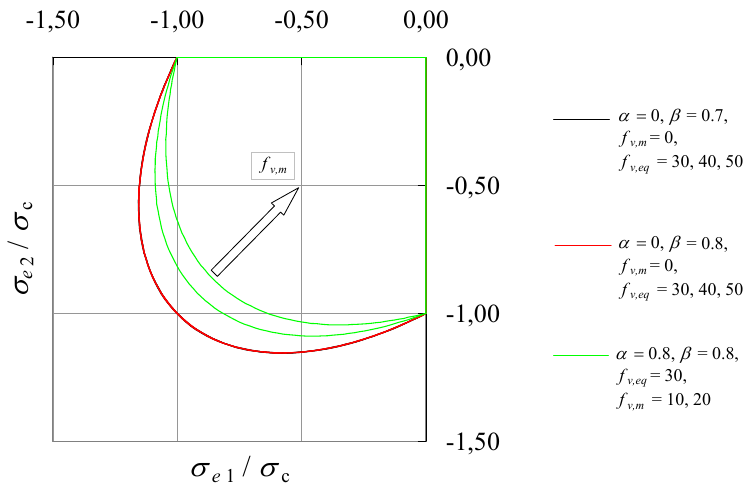
Figure 4: Dimensionless failure curves in bi-axial